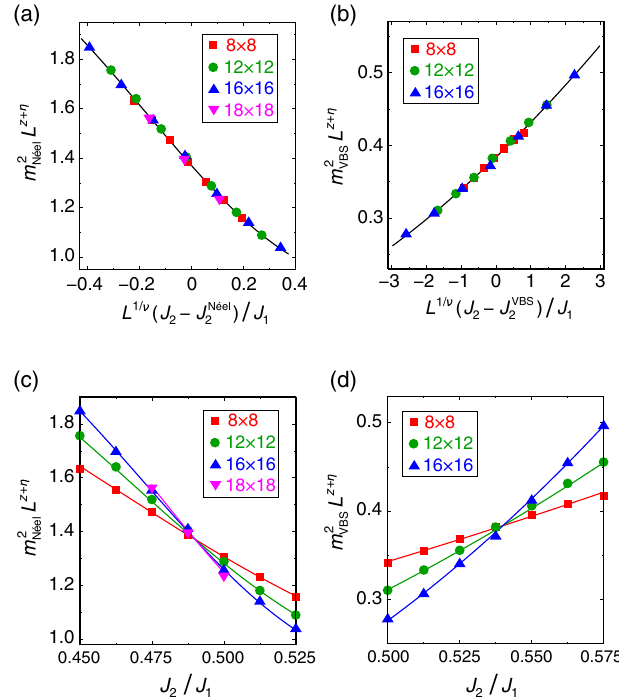
FIG. 8. Finite-size scaling analysis. (a),(c) Data collapse for N`eel-AFM order parameter. We assume J N´eel 2 =J 1 ¼ 0 . 49 and estimate the critical exponents z þ η and ν . The Bayesian scaling analysis [58,59] gives z þ η ¼ 1 . 410 ð 4 Þ and ν ¼ 1 . 21 ð 5 Þ . (b),(d) Data collapse for the VBS order parameter. The same analysis with assuming J VBS 2 =J 1 ¼ 0 . 54 gives z þ η ¼ 1 . 436 ð 6 Þ and ν ¼ 0 . 67 ð 2 Þ . Solid curves are the inferred scaling functions. In (a) and (c), the 18 × 18 data are added to corroborate the result. The figure shows that the conventional finite-size scaling analysis consistently supports the results obtained by the correlation ratio and level spectroscopy.